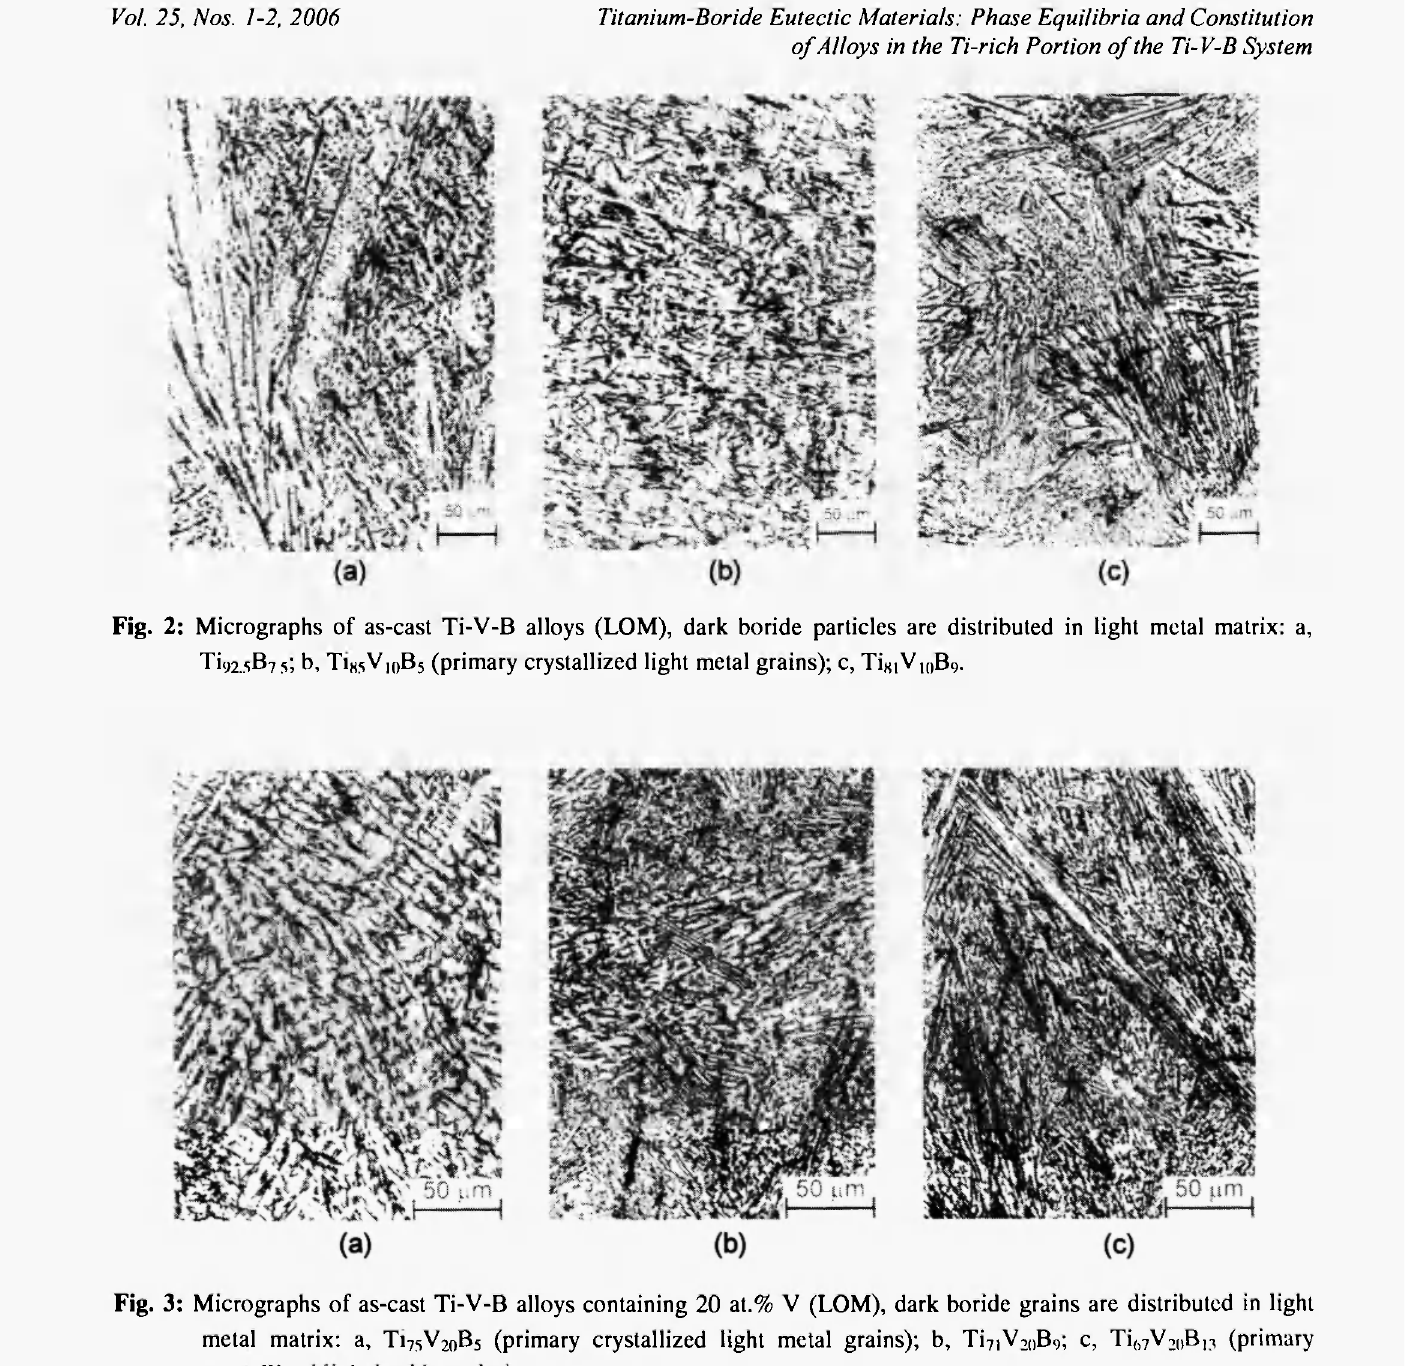
Fig. 3: Micrographs of as-cast Ti-V-B alloys containing 20 at.% V (LOM), dark boride grains are distributed in light metal matrix: a, T175V20B5 (primary crystallized light metal grains); b, Ti 7 |V2oB 9 ; c, Ti, )7 V :o B n (primary crystallized light boride